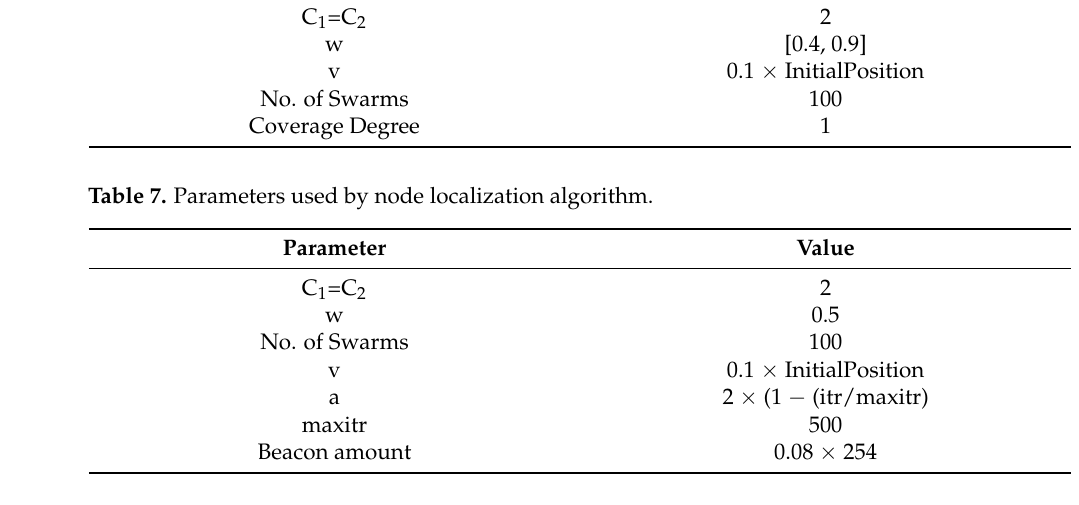
Table 8. Simulation parameters used in object trajectory and object detection modeling.